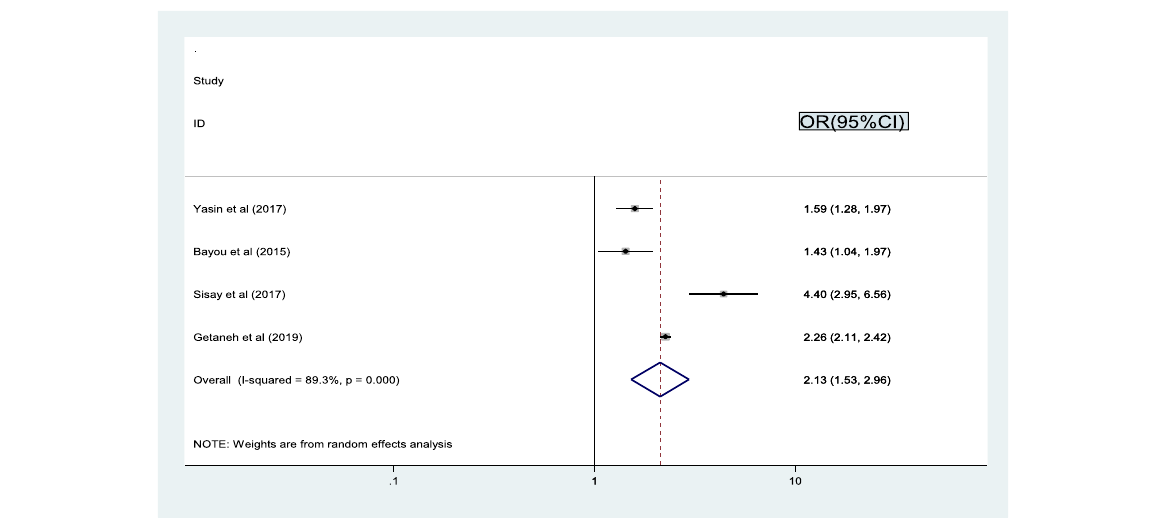
Fig. 7 Pooled odd ratio between disclosure and treatment failure